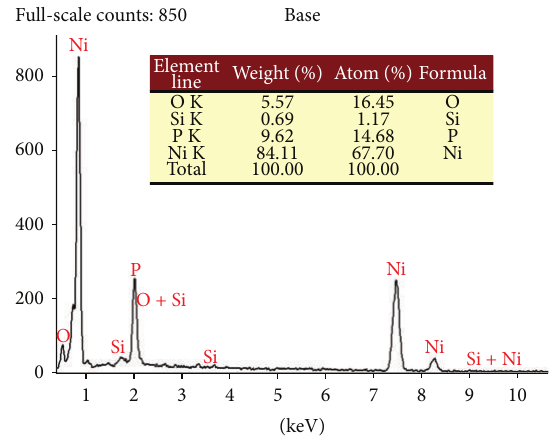
Figure 24: EDX diffractogram showing the % of elements present on the EN-coated Mg sample with 2% nano-SiO.